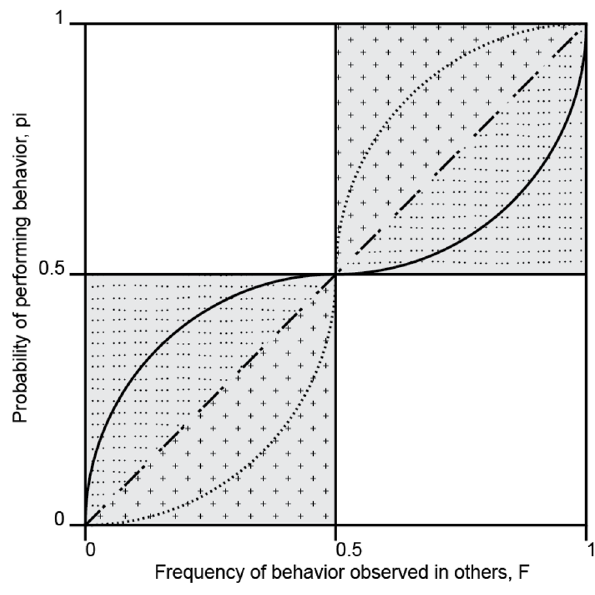
Figure 1. Three different kinds of conformity. In the conformity domain (shaded in grey) three different dynamics are distinguished: weak conformity (dotted domain; an example is the solid line), linear conformity (dash-dotted line), and hyper-conformity (crossed domain; an example is the dotted line). After Claidie`re and Whiten [8].